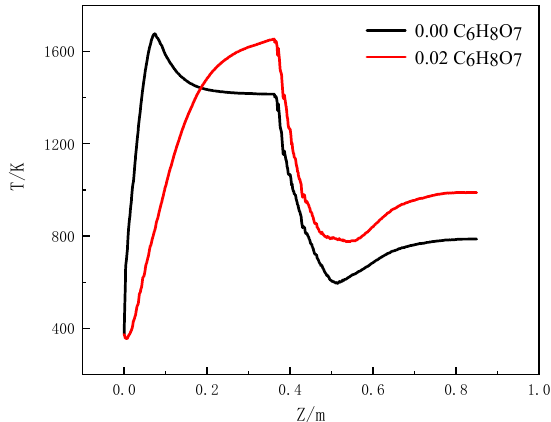
Figure 5. Temperature curves for the reactor with and without the addition of citric acid.